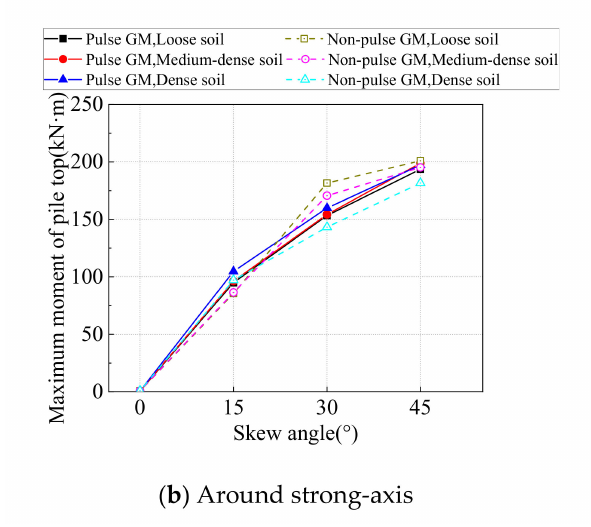
Figure 19. Maximum moment of pile